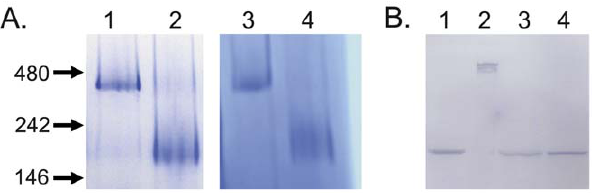
Figure 7. Quaternary structure analyses. A. BN-PAGE analyses of freshly purified WT AcrB (lane 1), AcrB P223G (lane 2), CL AcrB P223G/A225C/V777C in the absence of DTT (lane 3), and CL AcrB P223G/A225C/V777C in the presence of 4 mM DTT (lane 4). Positions of molecular markers were marked on the left of the gel (in kD). A 4–20% gradient gel was used in this experiment. B. Western blot analysis of membrane vesicles extracted from BW25113 D acrB expressing WT AcrB (lanes 1 and 3) or CL AcrB P223G/A225C/V777C (lanes 2 and 4) in the absence (lanes 1 and 2) or presence (lanes 3 and 4) of 4 mM DTT.